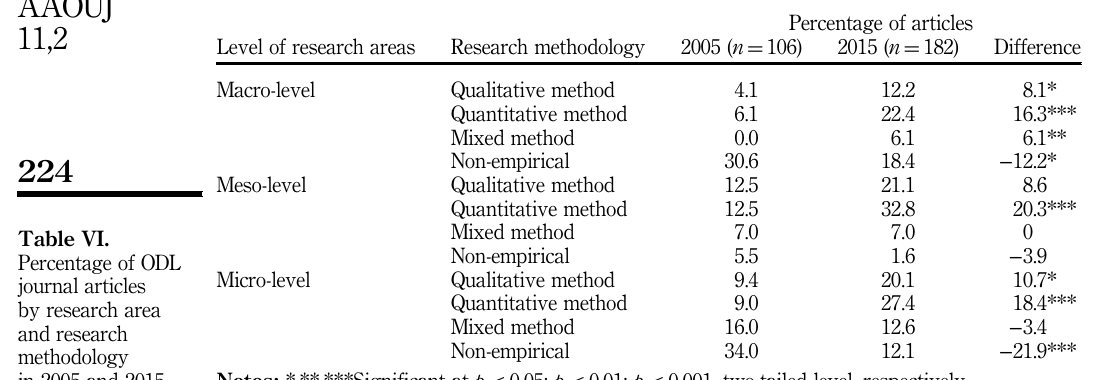
Table VI. Percentage of ODL